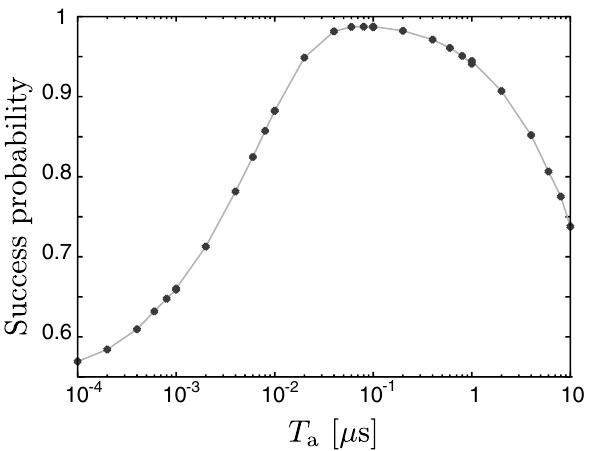
ρ est ( t , T a ) , ρ c ( t ) time-averaged over a 1000 µ s period, as a [ ]